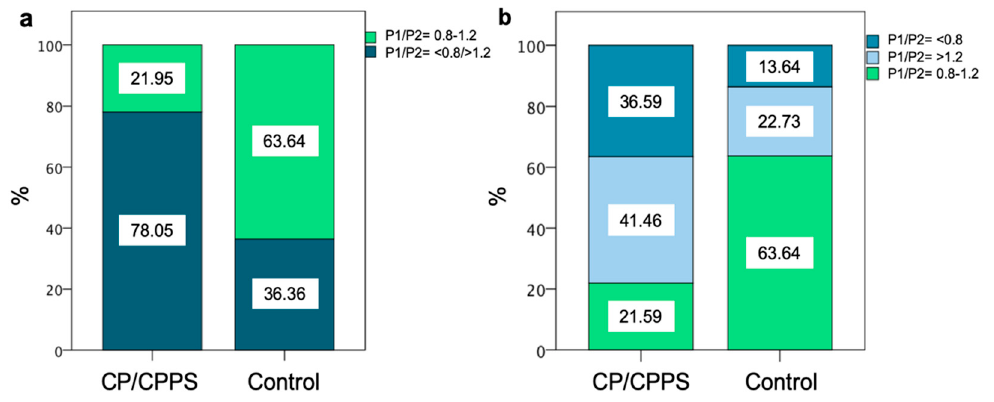
Figure 4. Correlations between HDS and sperm parameters. Significant negative correlations were shown between HDS and total sperm number (r = − 0.366, p < 0.05, not shown), sperm concentration (r = − 0.420, p < 0.01) ( a ) and normal morphology (r = − 0.399, p ≤ 0.01) ( b ). HDS were significantly positively associated with head defects (r = 0.378, p < 0.05, not shown) as well as peroxidase-positive cells (r = 0.342, p < 0.05) ( c ).